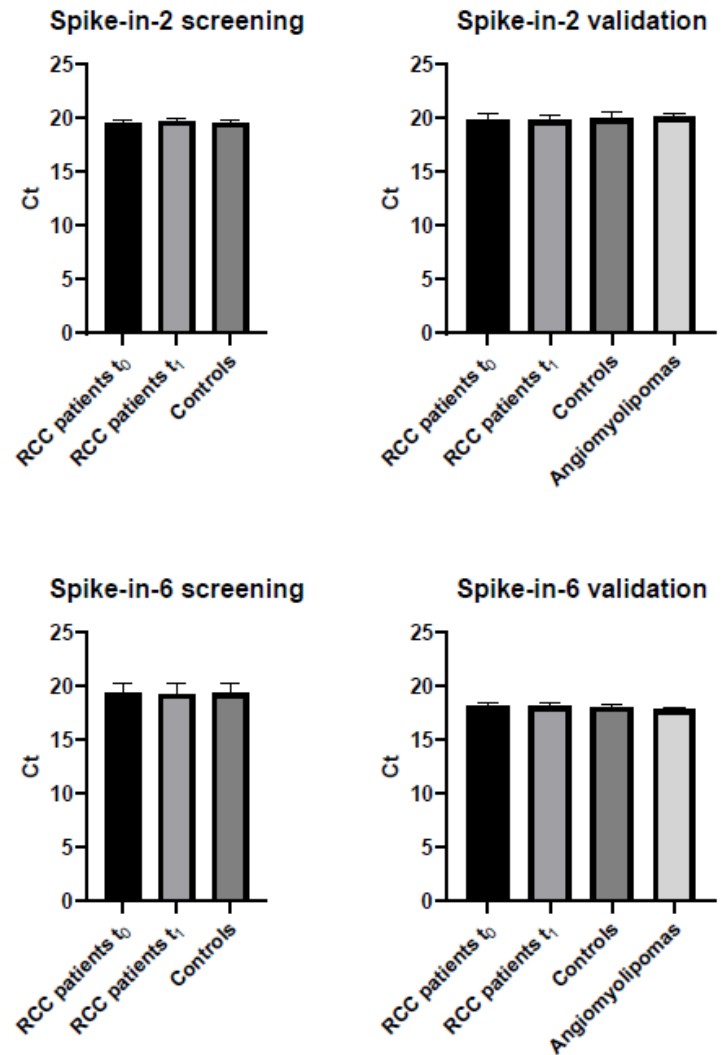
Figure 1. Differences in expression levels of the synthetic spike-in RNAs among the study groups. Spike-in 2 monitors the RNA isolation step and spike-in 6 monitors the retrotranscription efficiency. Expression levels are represented as Ct values and error bars represent standard deviation. ANOVA p >